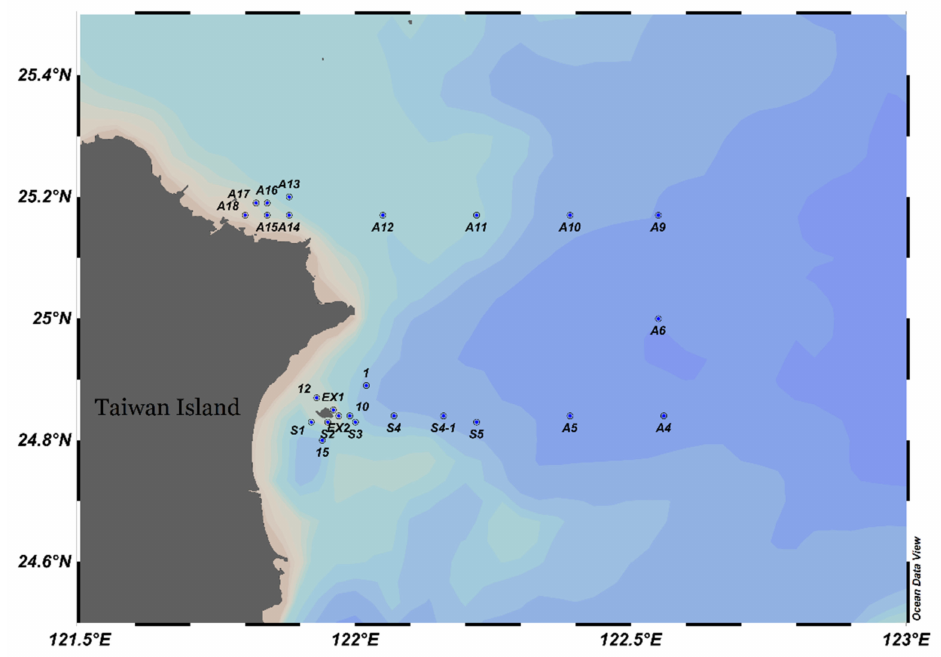
Figure 1. Research area and sampling